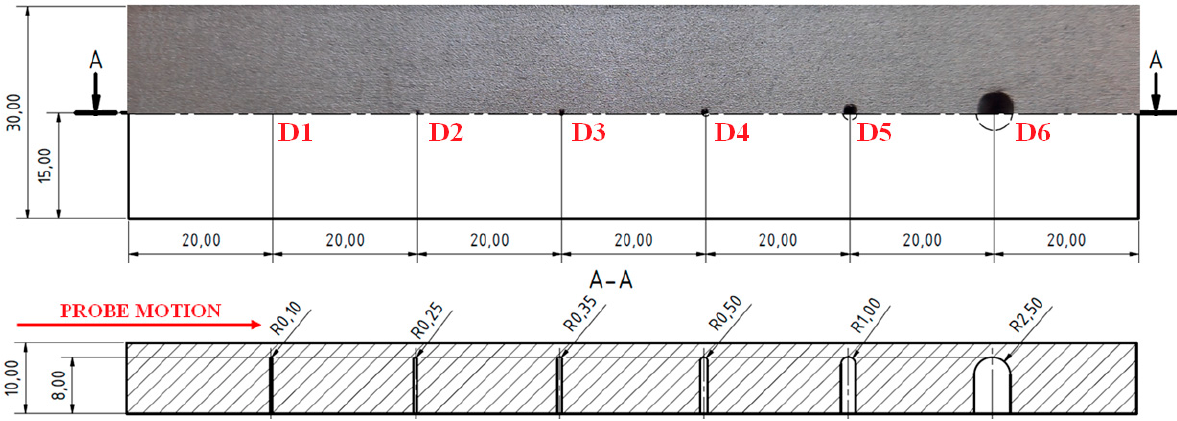
Figure 13. S3 sample.